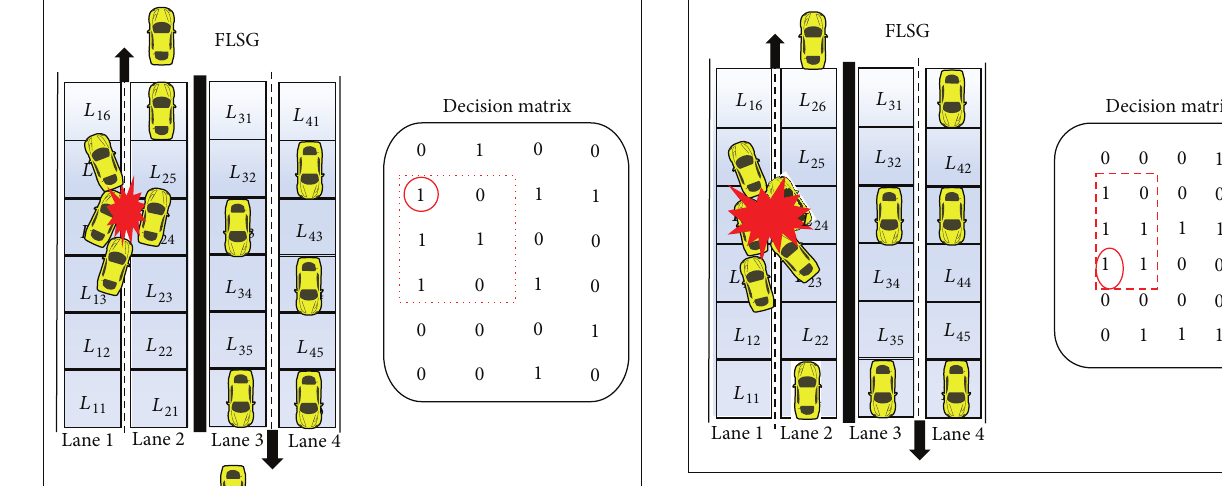
Figure 8: Scenario of abnormal acceleration with respective deci- sion matrix.